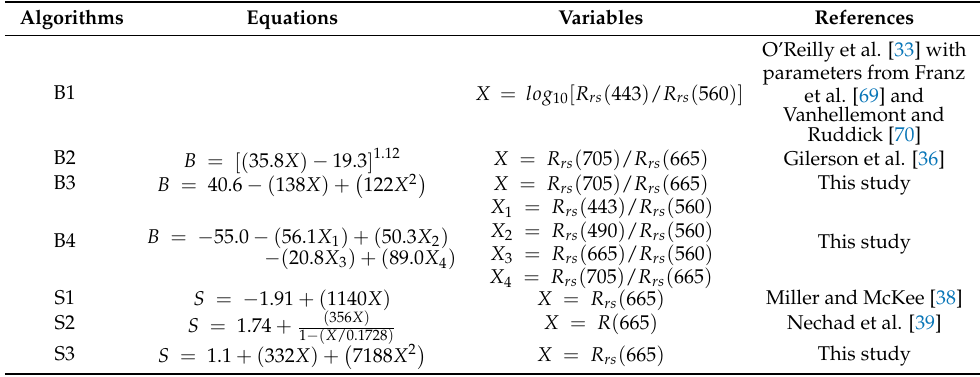
Table 2. Table showing the different satellite-retrieval algorithms and their coefficients used in the present work to estimate chlorophyll-a ( B ) and total suspended matter ( S )